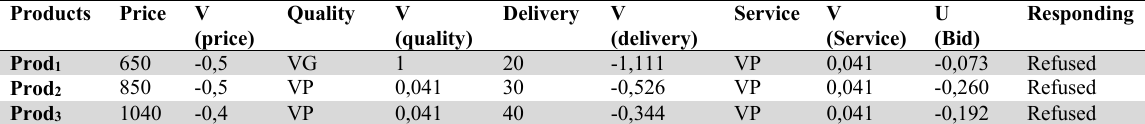
Round 1: BPNA Conceding and responding